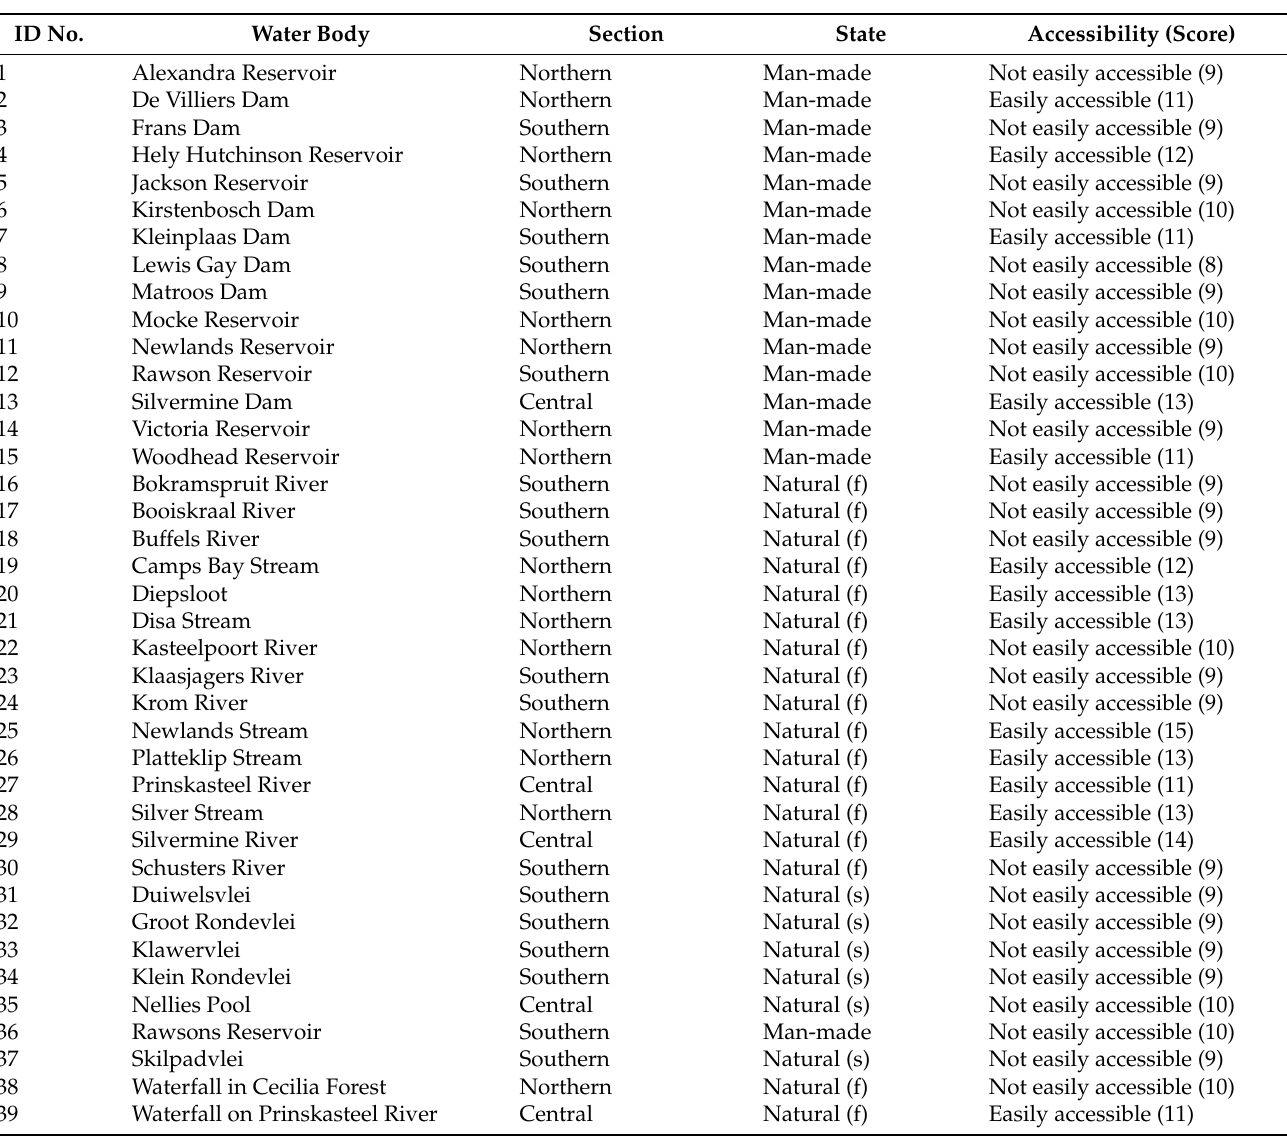
Table A4. Water features in Table Mountain National Park listed by section, state and level of accessibility. Natural (f) relates to flowing water features, such as rivers and streams; natural (s)